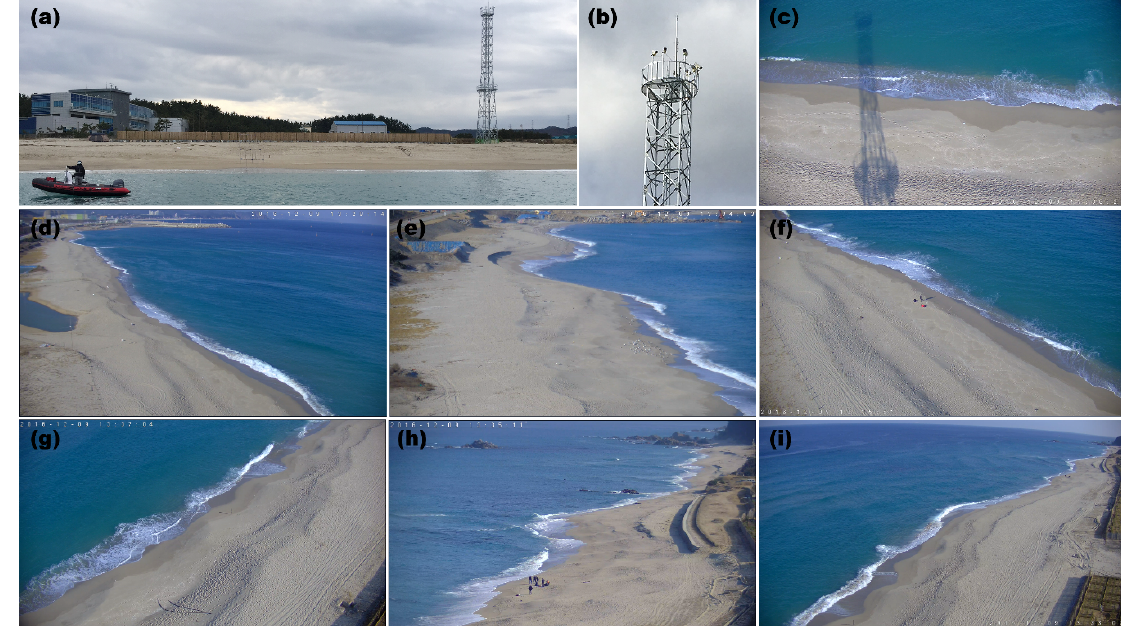
Figure 2. ( a , b ) Photographs of the video monitoring tower installed in Hujeong Beach, December 2016. ( c – i ) Examples of shoreline image data measured by the video cameras. These images are taken from [12].